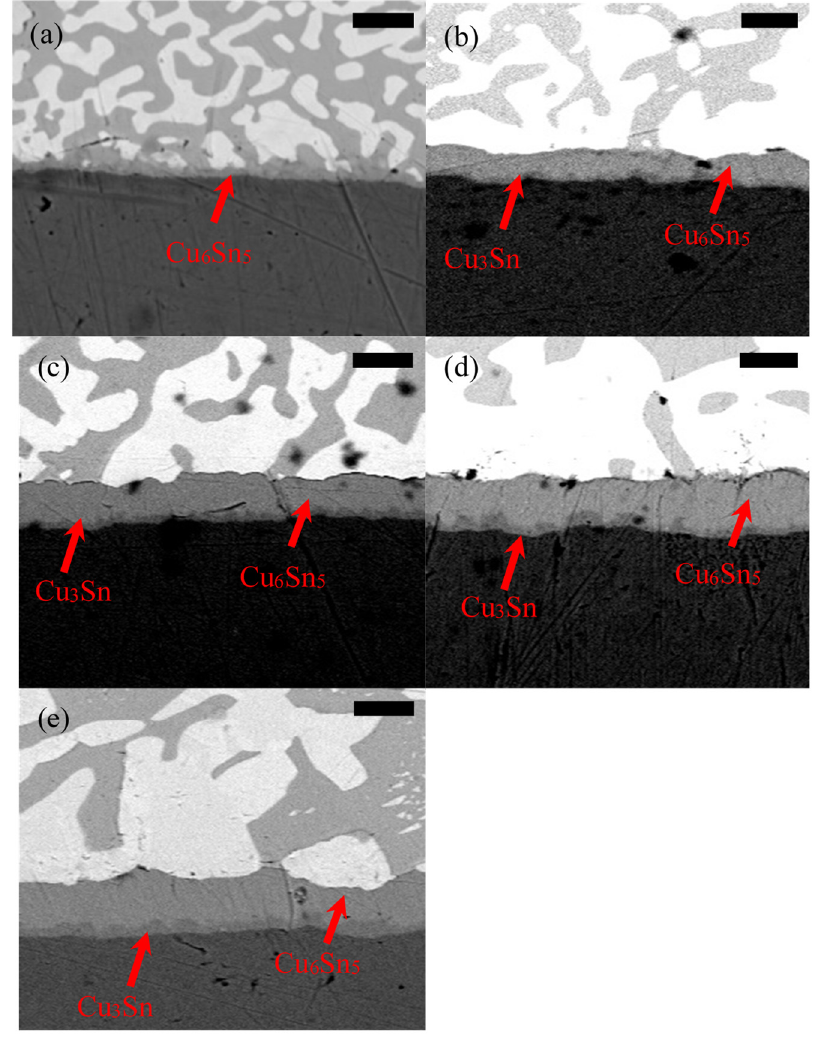
Figure 14. SEM micrograph of 42Sn58Bi after ( a ) 0 cycles, ( b ) 250 cycles, ( c ) 500 cycles, ( d ) 750 cycles and ( e ) 1000 cycles. The scale bar is 4 µm in all images.